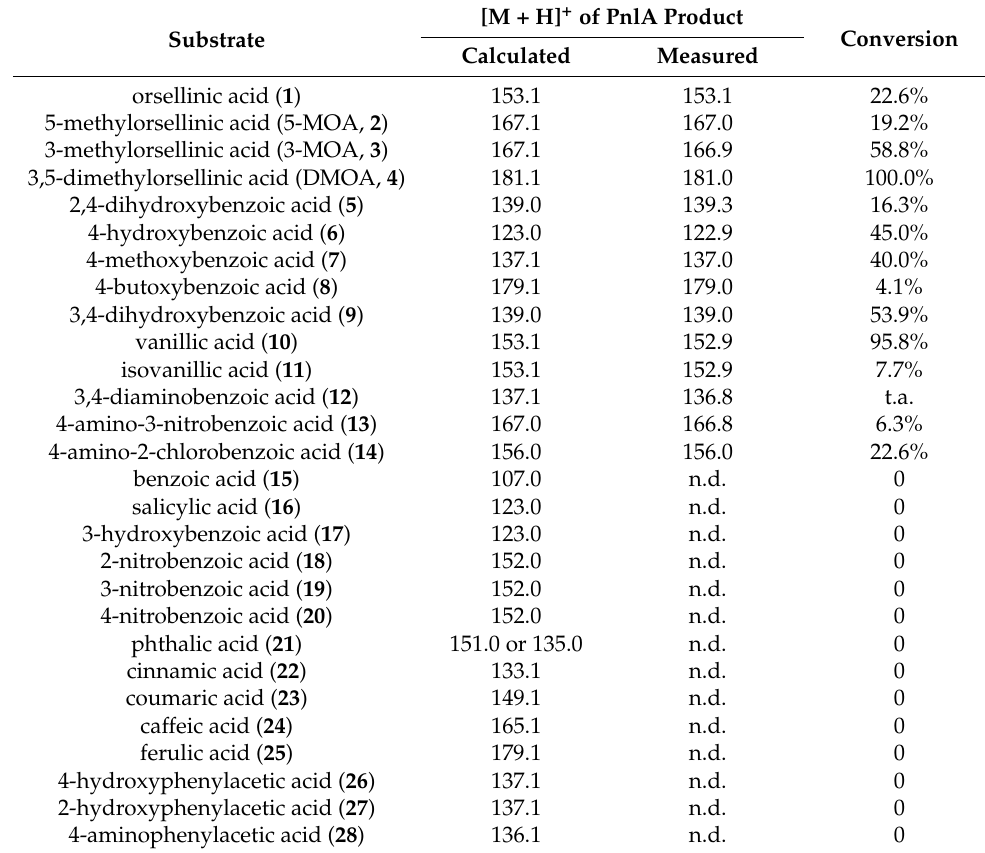
Table 1. Specific activities of PnlA toward different benzoic acid